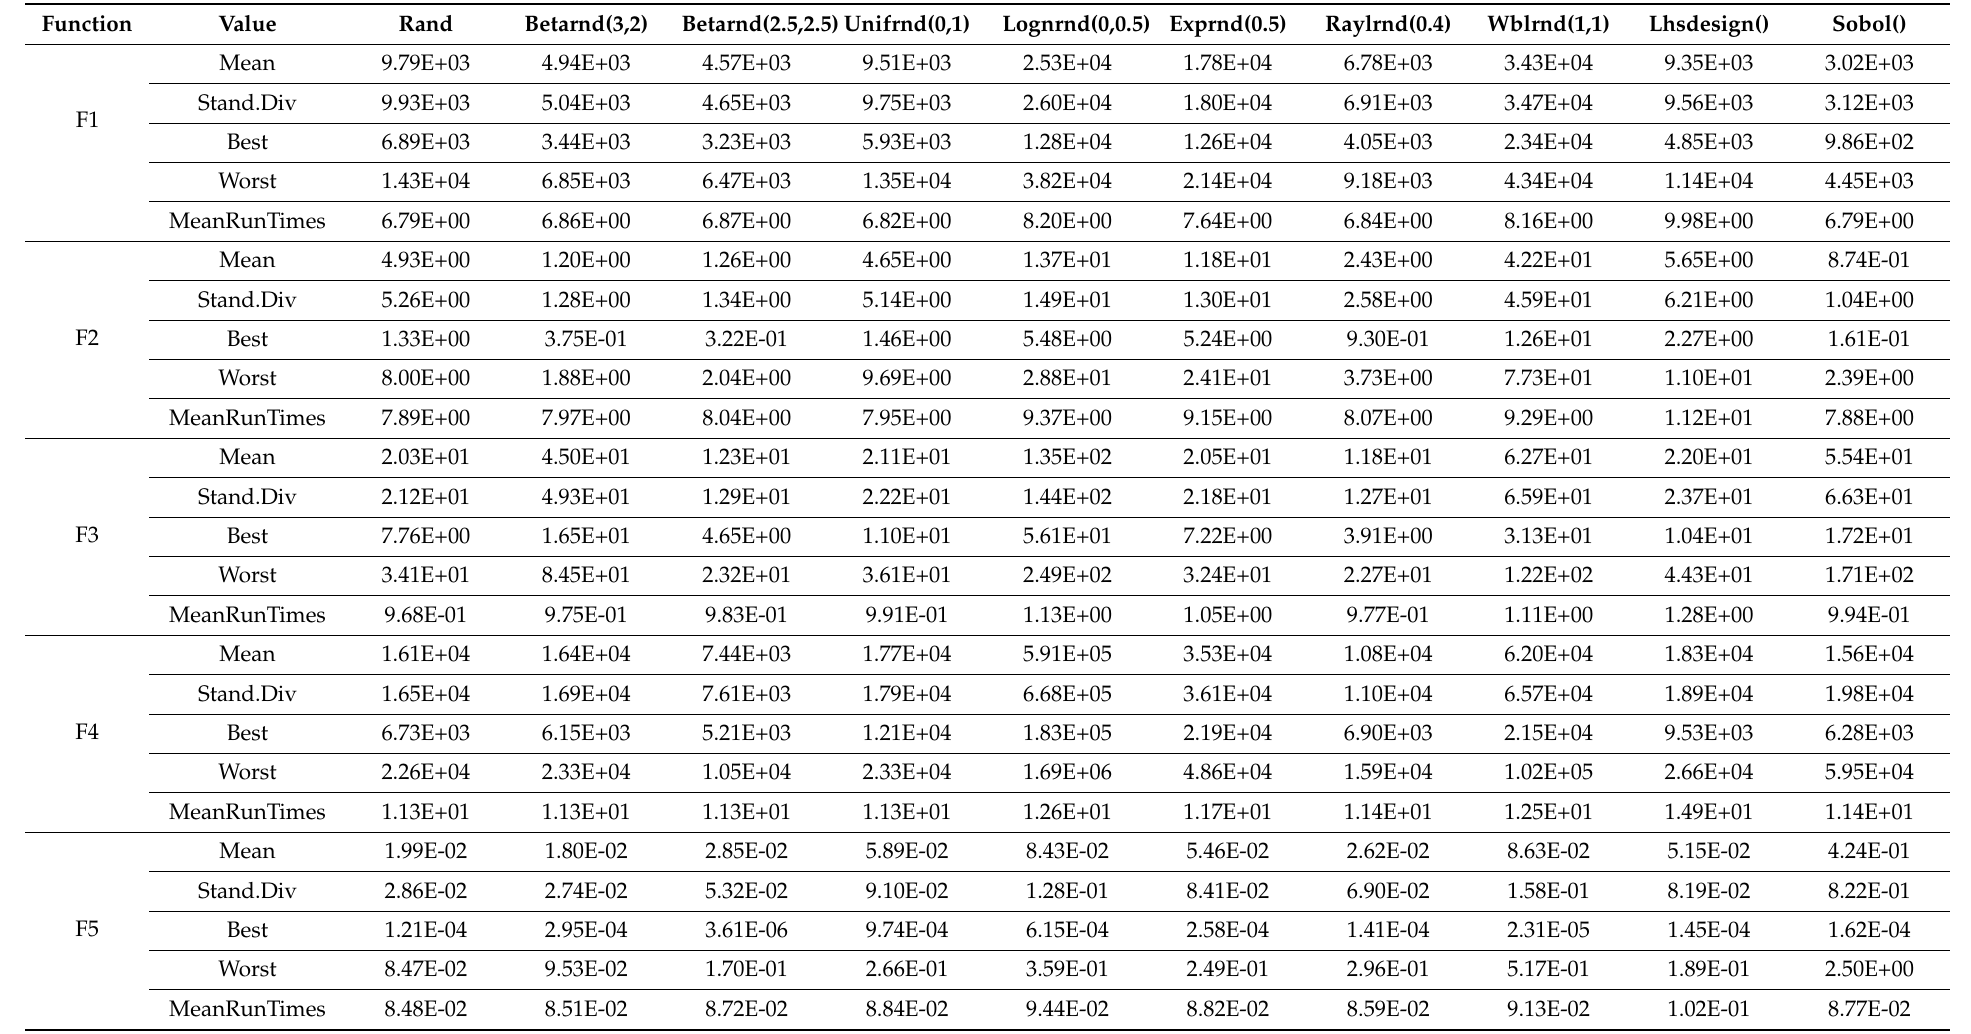
Table 17. Results for